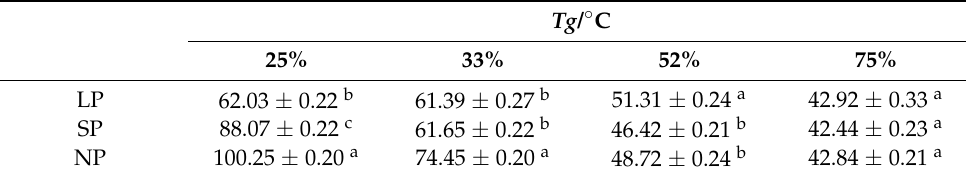
Table 2. Glass transition temperature ( Tg ) of different particle size